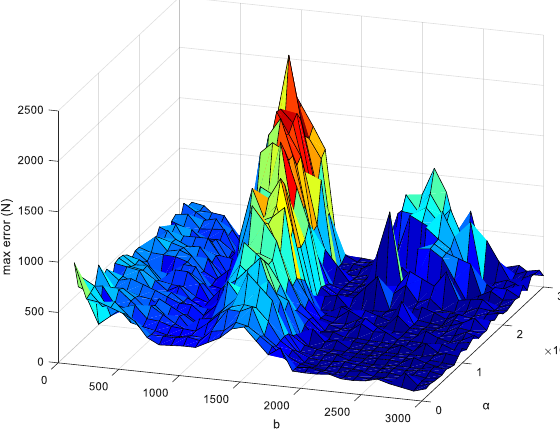
Figure 9. Influence of control parameters on control error.